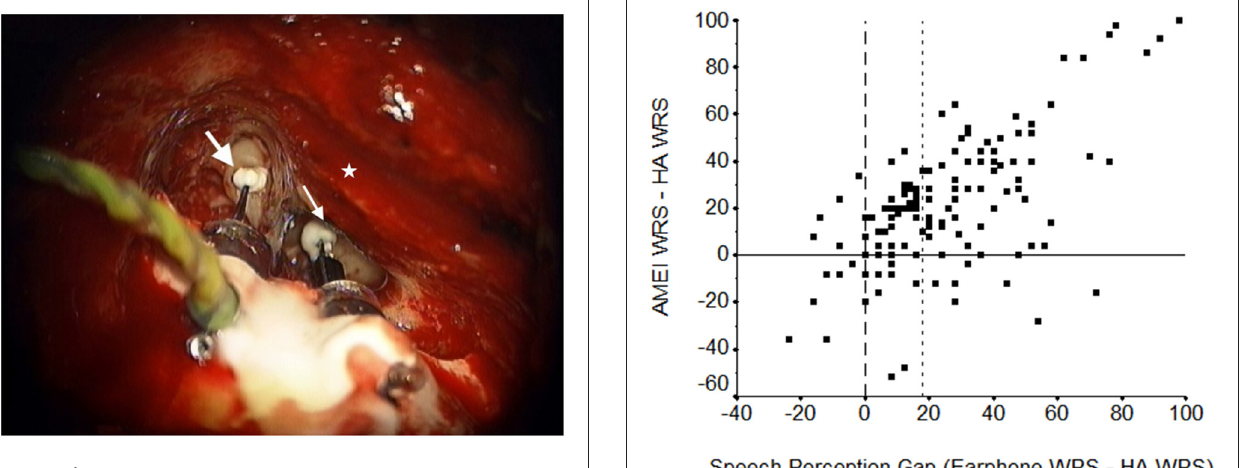
FIGURE 1 | Sensor transducer (large white arrow) and Driver transducer (small white arrow) bodies cemented in mastoid with tips attached to the incus and stapes respectively as viewed through the right-side mastoid exposure. Star represents the posterior external auditory canal.